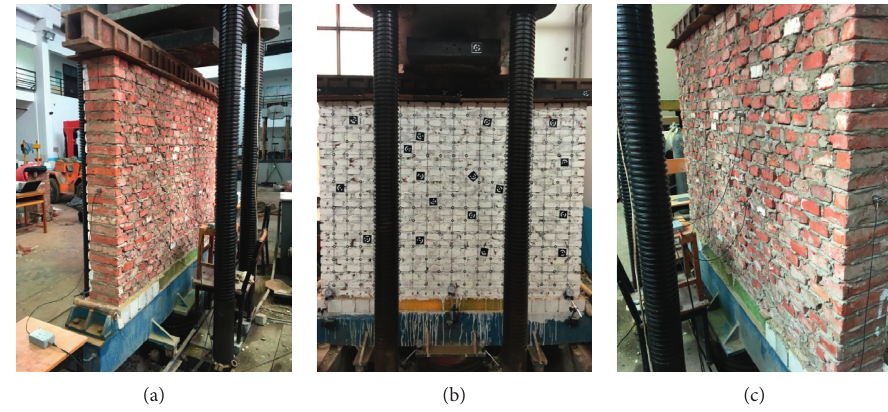
Figure 1: The scene photograph.